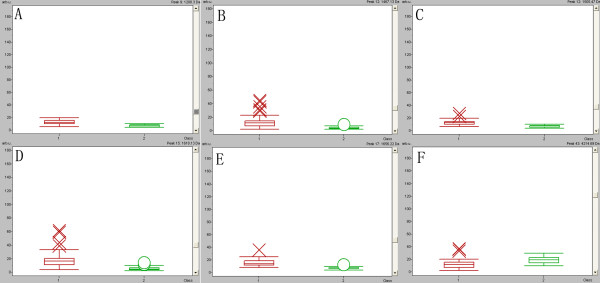
Box-and-whiskers plot calculated from the areas of the six proteins (m/z 1208 (A), 1467 (B), 1505 (C), 1618 (D), 1656 (E) and 4215 (F)) selected for the diagnostic model. Red represents colorectal cancer, Green represents healthy volunteers (P < 0.01 versus ctrl).